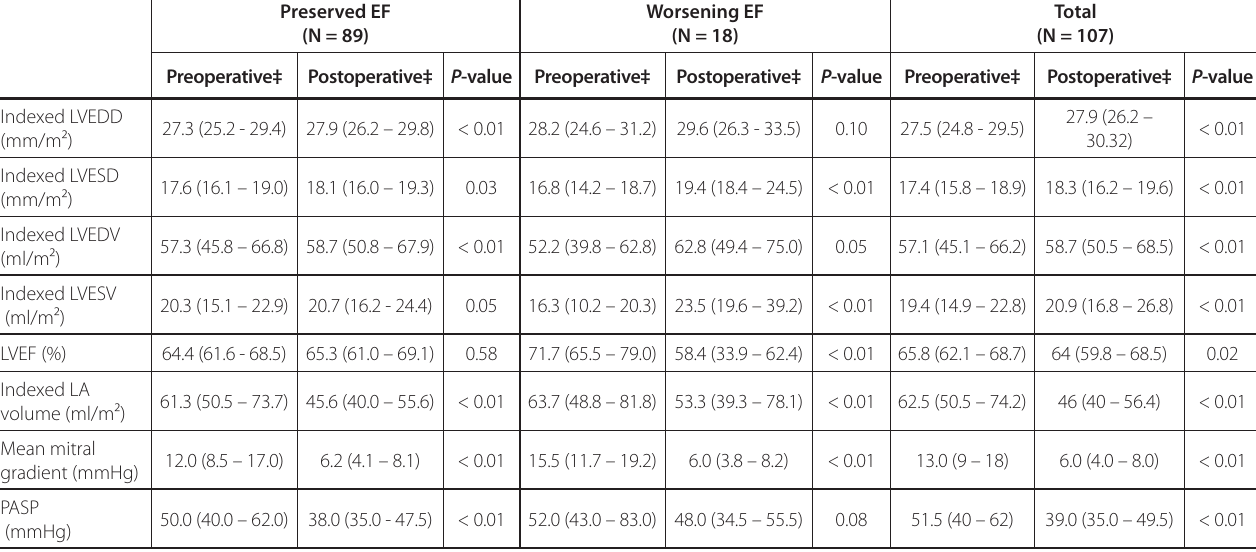
Table 2 . Variation of echocardiographic data among preoperative and postoperative periods.